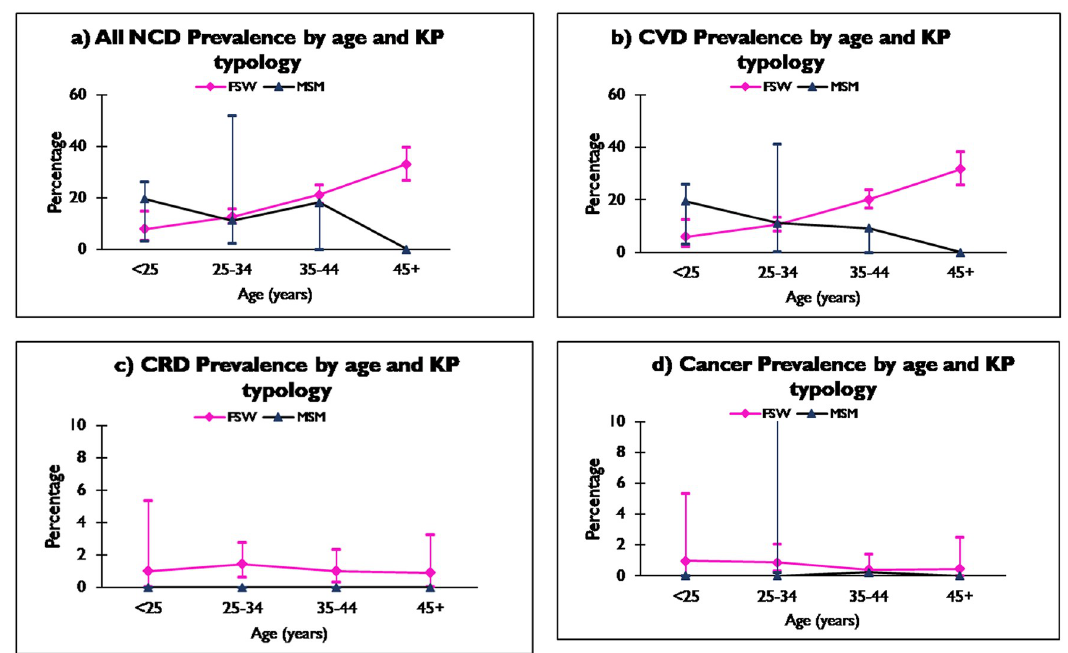
Fig 1. a. All NCD prevalence by age and KP typology. b. CVD prevalence by age and KP typology. c. CRD prevalence by age and KP typology. d. Cancer prevalence by age and KP typology.